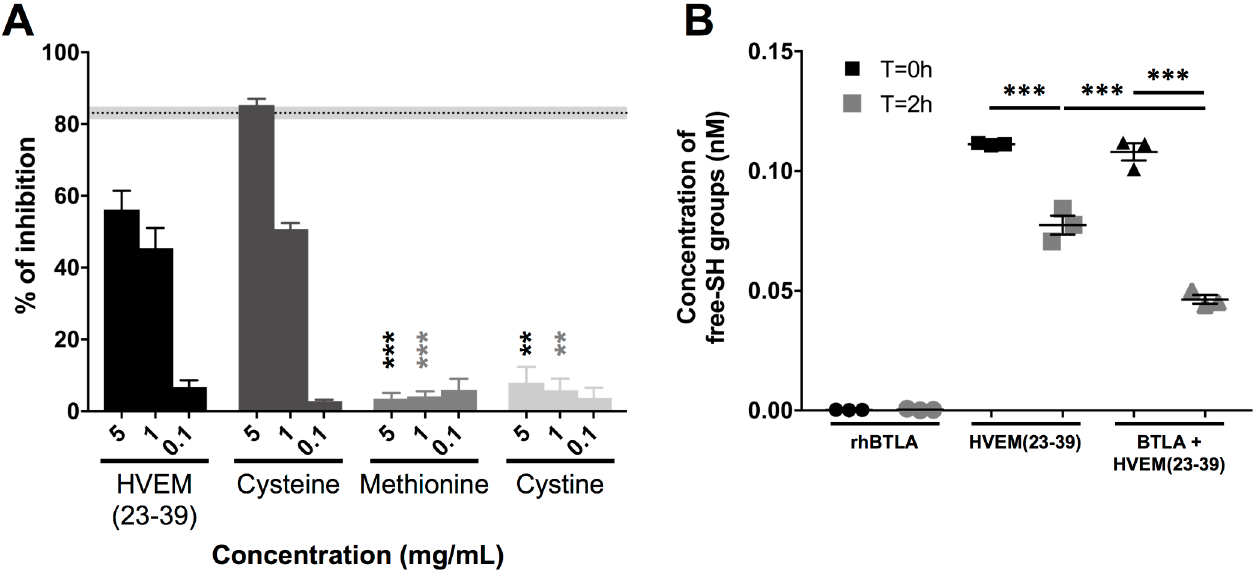
Fig 6. Free cysteine blocks the ligation between BTLA and HVEM. (A) The effect of increasingconcentrations (5, 1 and 0.1 mg/mL) of free amino acids were tested in BTLA/HVEM ELISA (three experiments in triplicate). The percentage of inhibitionwas calculatedin relationto the negative control (PBS). The gray and dotted back lines correspond to the percentages of inhibitionobserved with an anti-BTLA blockingantibody (Mean +/-SEM). Statistical analysiswas performed by comparing each concentration of residueor peptideto the same concentration of Cys. (B) Assessment of free thiol groupsover time in rhBTLA-Fc protein and HVEM(23–39) peptidealone or mixed together. ** : p < 0.01 and *** : p < 0.001 followingOne-way ANOVA and Dunn’s (A) or Dunnett’s (B) post-test.